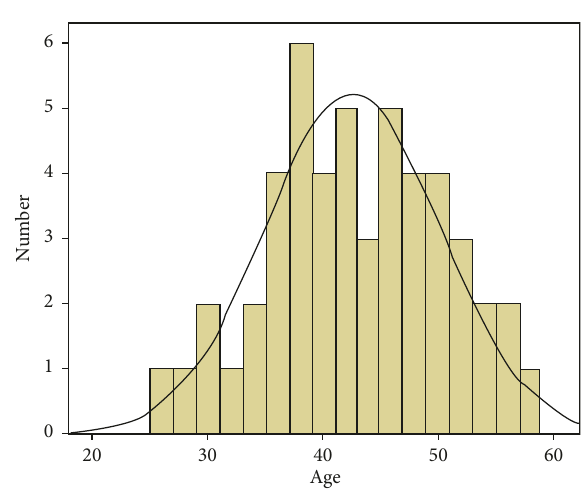
Figure 3: Age of participants in the